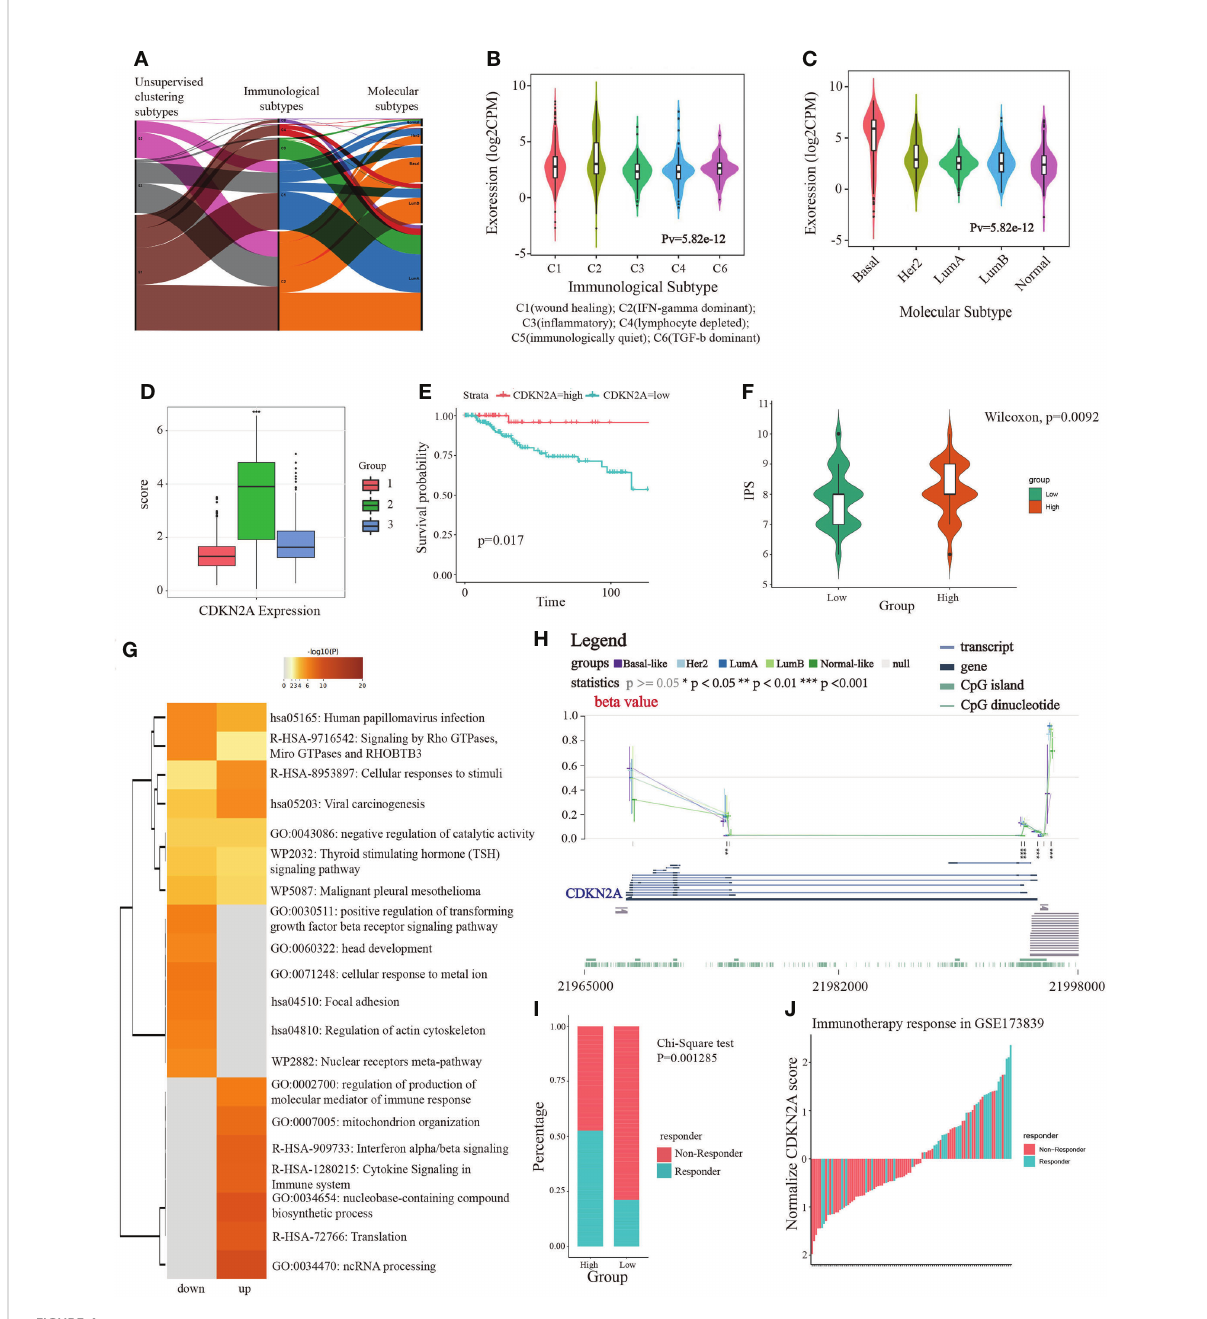
FIGURE 4 The linkage of CDKN2A to immunotherapy and TNBC. (A) The correlation between molecular subtypes, immunological subtypes, and our unsupervised subtypes in BRCA. (B) The relationship between CDKN2A expression and immunological subtypes of BRCA. (C) The relationship between CDKN2A expression and molecular subtypes of BRCA. (D) The comparison between CDKN2A expression and unsupervised subtypes of BRCA. (E) The survival value of CDKN2A in TNBC. (F) The comparison between IPS score and high and low CDKN2A expression subpopulations in TNBC. (G) The function annotation analysis of up-regulated and down-regulated SDEGs in high and low CDKN2A expression subpopulations. (H) The comparison between methylation status of CDKN2A and molecular subtypes of BRCA. (I, J) The correlation between immunotherapy response status and CDKN2A expression in TNBC via chi-square test. The P values of the fi gure are shown as follows: *P < 0.05. **P < 0.01. ***P <